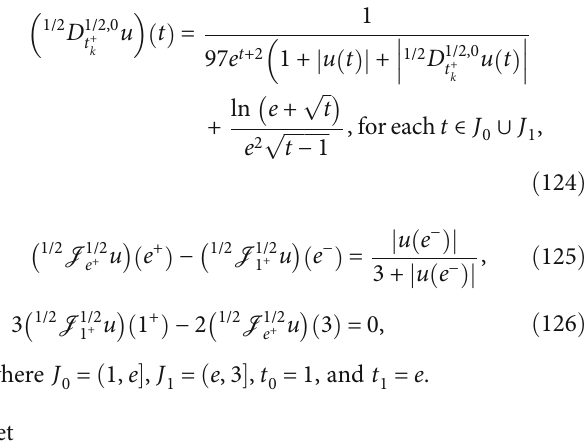
ffiffiffiffiffiffiffiffiffiffiffiffiffiffiffiffiffiffiffiffiffiffiffiffi 2 π